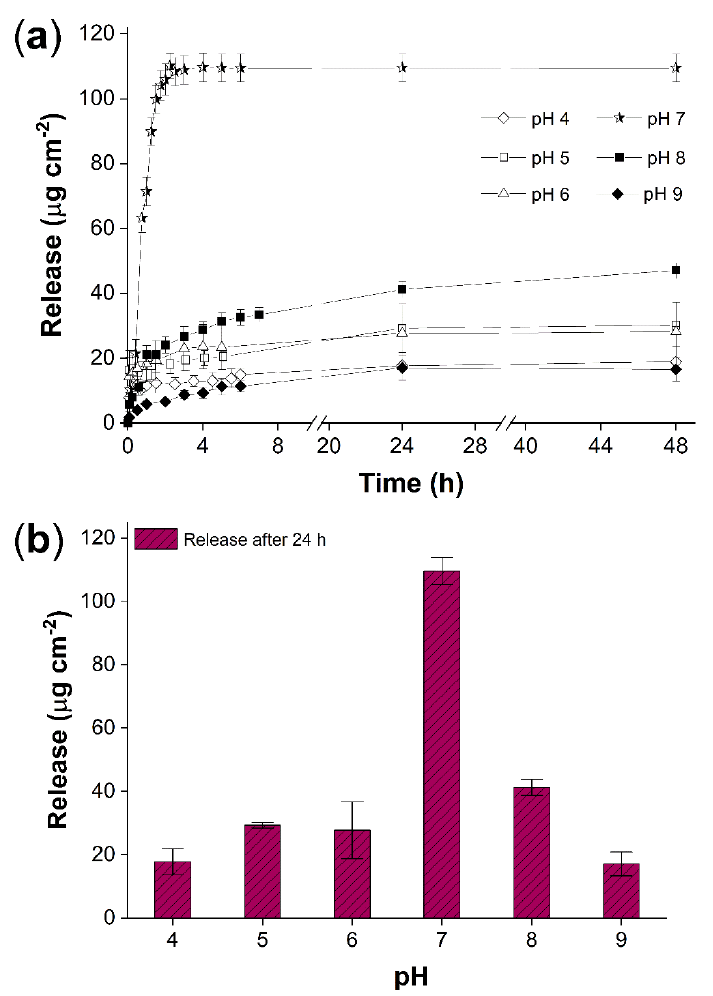
Figure 10. (PP- g -MMA)- g -NVI (23/5.5%): ( a ) Release of vancomycin in phosphate buffers 0.1 M at different pH and ( b ) release reached at 24 h.